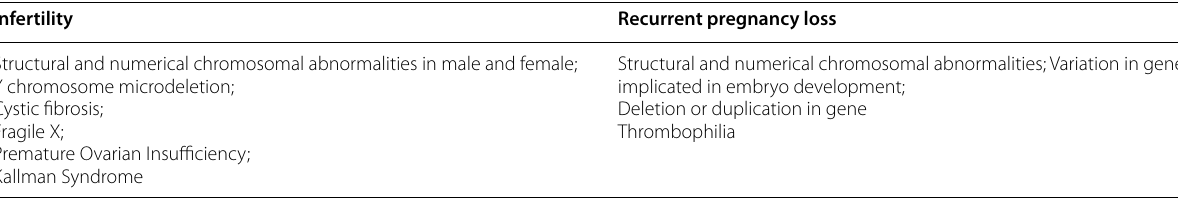
Table 3 Common Genetic Problems that can cause infertility and RPL Infertility Recurrent pregnancy loss Structural and numerical chromosomal abnormalities in male and female; Y chromosome microdeletion; Cystic fibrosis; Fragile X; Premature Ovarian Insufficiency; Kallman